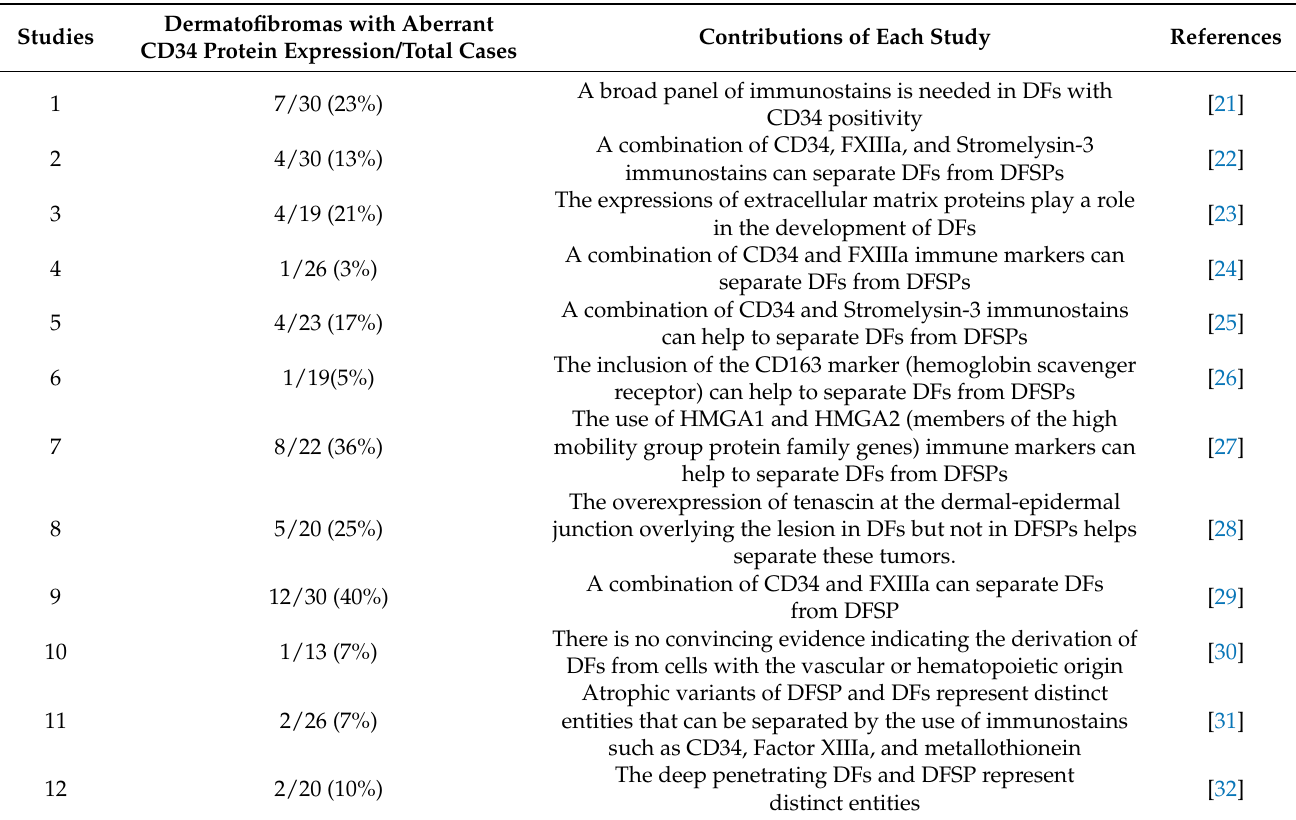
Table 1. Data from individual studies of dermatofibroma with aberrant expression of CD34